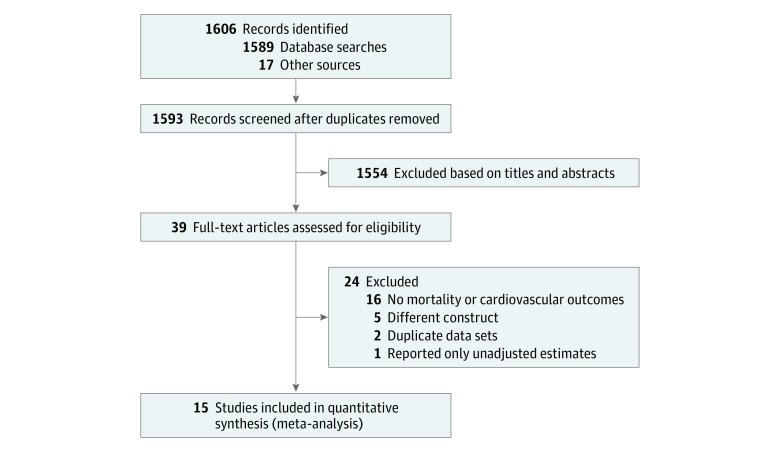
Flowchart of Study Selection